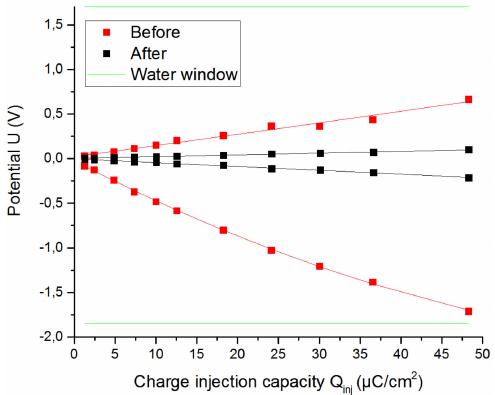
Figure 19. Extreme polarization potentials for the graphene electrode F before and after the activation using a stimulation signal of 200 µ s.